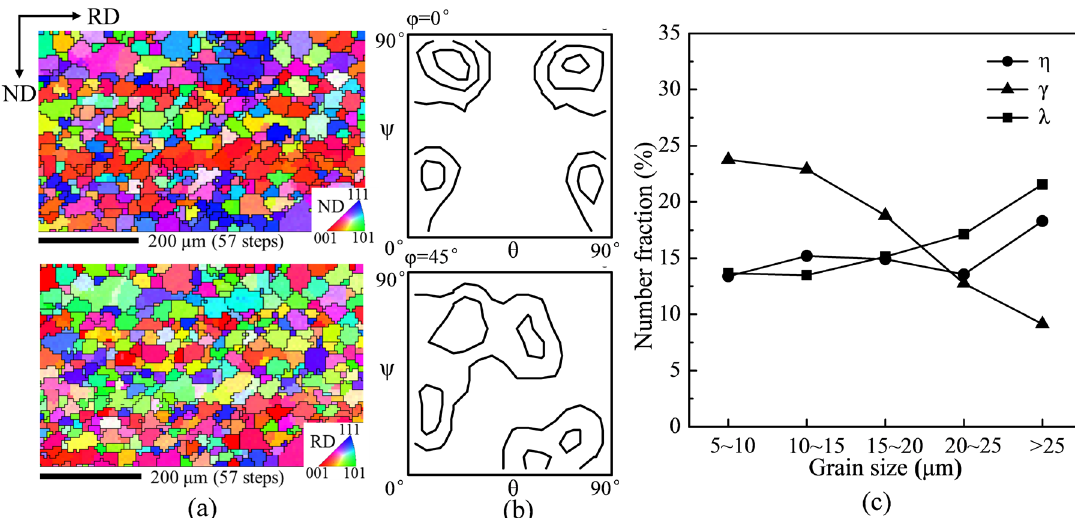
Figure 6. (a) Orientation image maps, (b) constant φ = 0° and 45° sections of ODFs (levels: 1, 2, 3...) and (c) number fraction distribution of main texture components in different size ranges in Fe-4.5 wt.% Si sheets after decarburization annealing at 830 °C for 83% reduction.